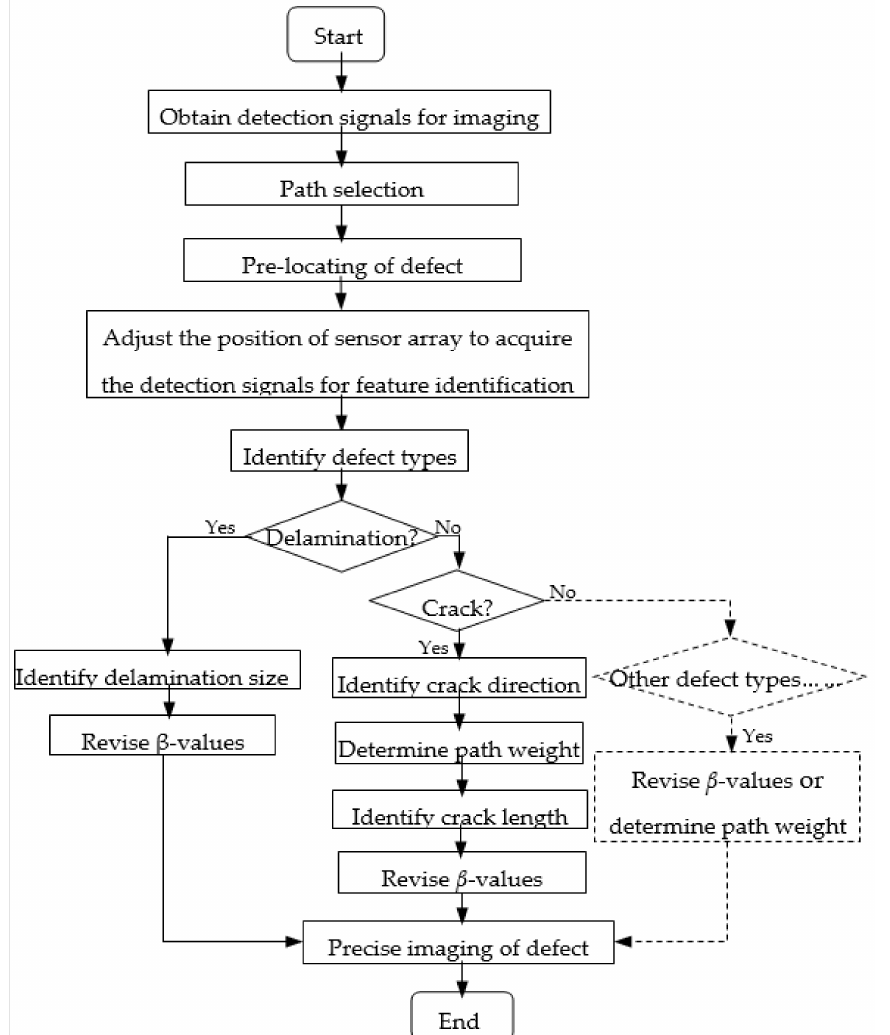
Figure 2. The flow diagram of the proposed method.